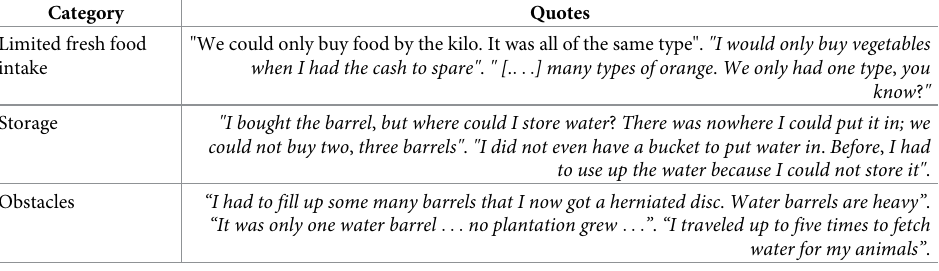
Table 5. Categories and quotes regarding the perception of what life was before the Boardwalk Cistern. Semi-arid region of Alagoas, Brazil,